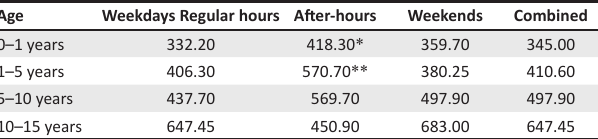
TABLE 6: 75th percentile of Dose Length Product (mGy * cm) data distribution, categorised for time and age for computed tomography brain examinations at